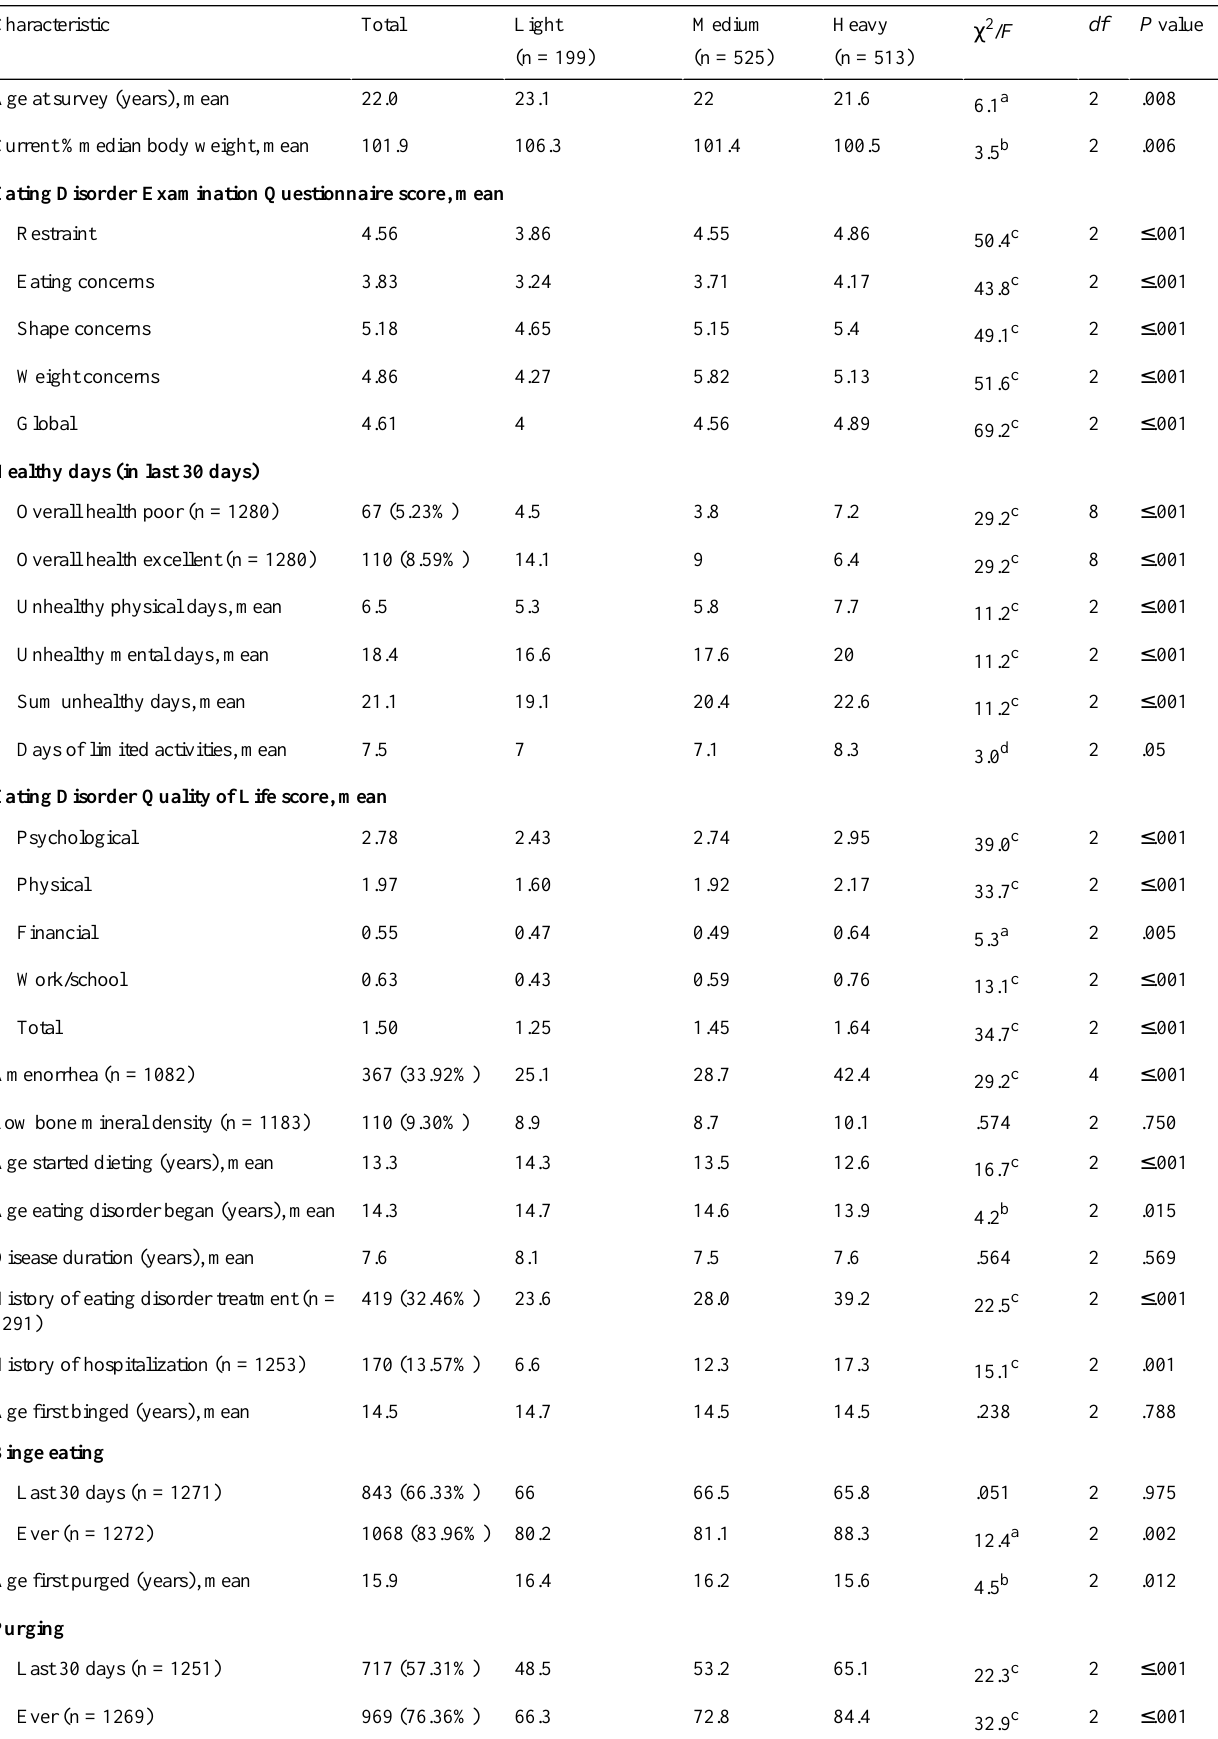
Table 3. Pro-eating disorder (pro-ED) website usage and associated eating disorder activities and